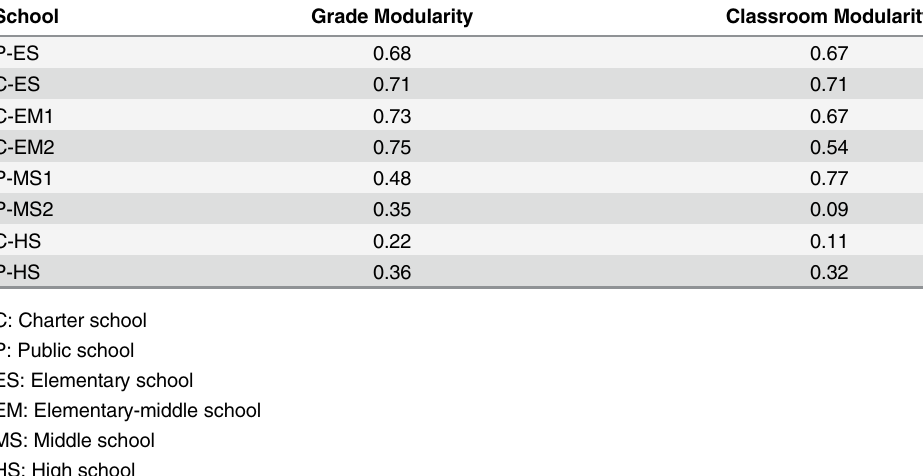
Table 3. Modularities of the networks based on grades and